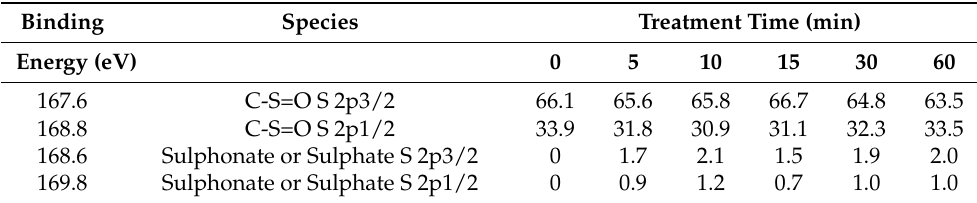
Table 3. Assignments [15] and % areas for S 2p 3/2 and S 2p 1/2 peaks as determined by curve-fitting the spectra in Figure 6.